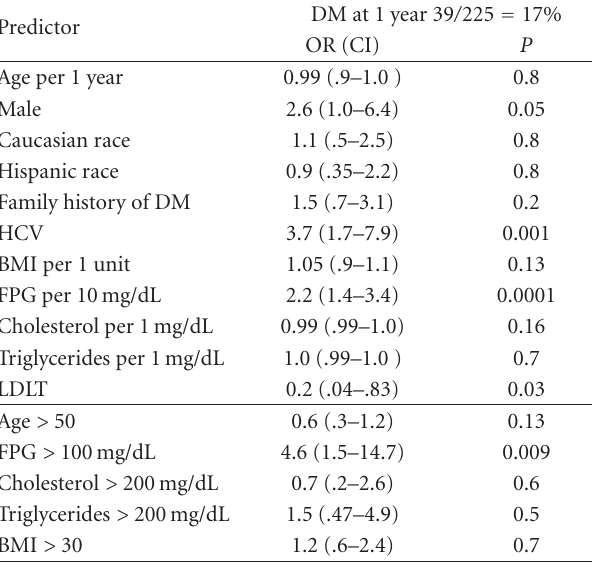
Table 4: Pretransplant predictors of NODAT in univariate analysis.